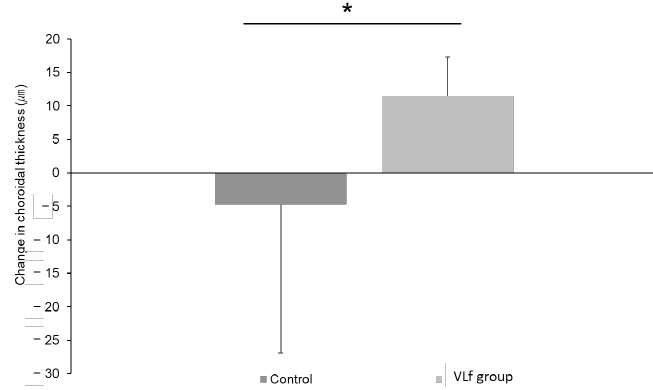
Figure 4. The change in the choroidal thickness at 24 weeks in the subsequent subjects aged 8 to 10 years ( n = 30 eyes comprised of 10 and 20 eyes in the VLf and control groups, respectively). The change in the choroidal thickness in the VLf group is significantly ( p = 0.014) larger than in the control group. * p < 0.05, Mann–Whitney U-test. VLf: violet light eyeglasses